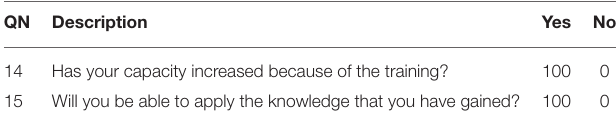
TABLE 8 | Learning–knowledge/skills abilities gained (in